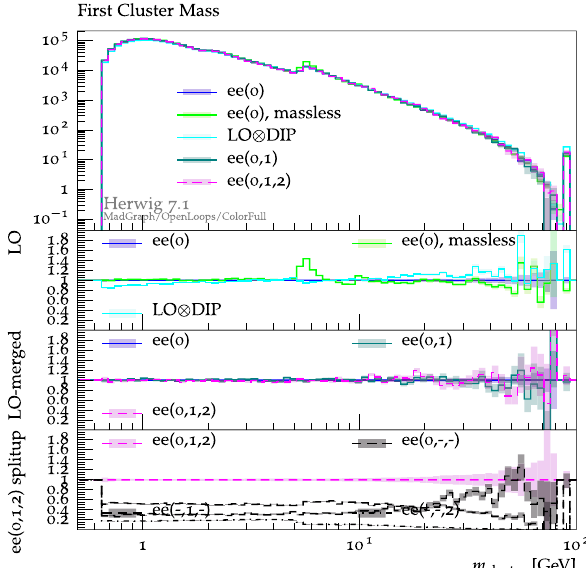
Fig. 7 Mass spectrum of the Herwig cluster hadronization model at LEP. We show the mass spectrum of primary clusters. The merging hardly modifies the spectrum. In the lowest ratio plot the contributions of ee ( 1 , 2 , 3 ) are split up into multiplicities. Note: The mass spectrum of primary colour-singlet clusters is not connected with the clustering of the cluster algorithm described in Sect. 3.3